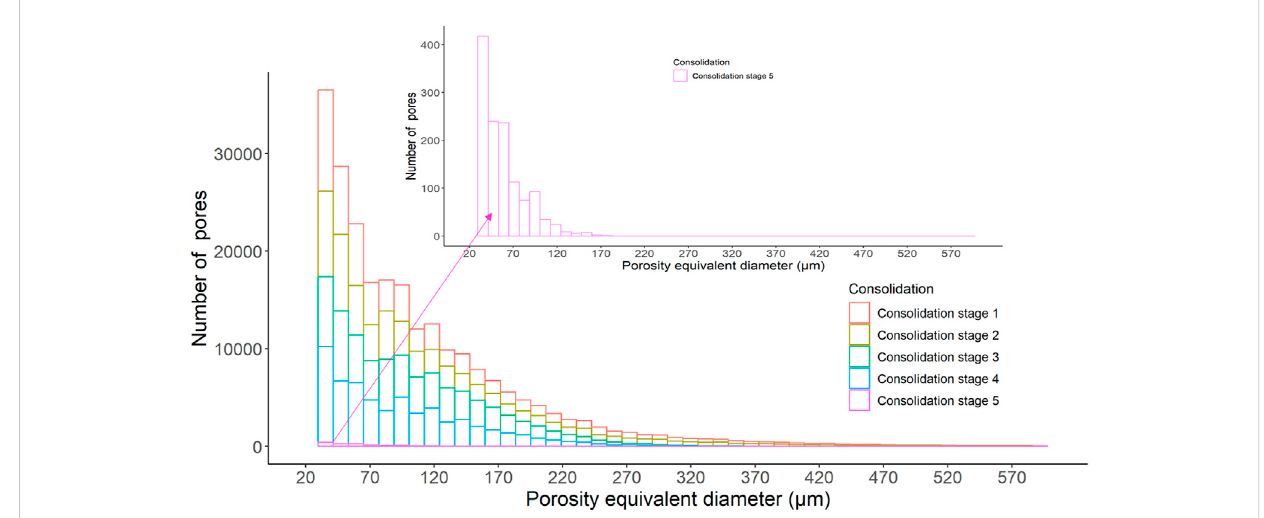
FIGURE 12 The frequency of the distribution of porosity equivalent diameter at different consolidation stages.